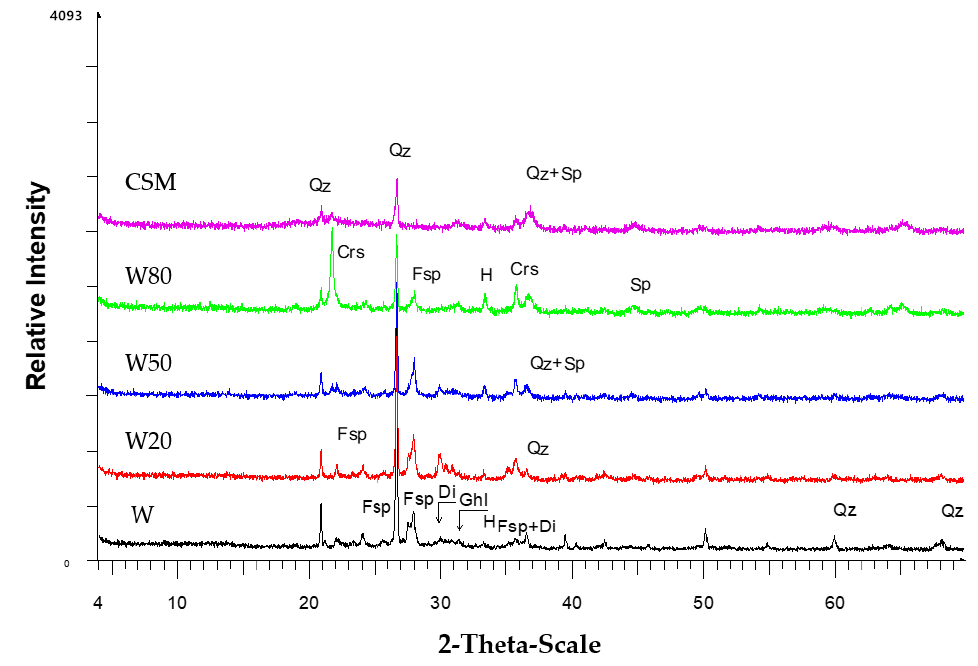
Figure 4. Powder X-ray diffraction patterns of the fired samples at 1000 °C. Abbreviations: Qz—quartz, Crs—cristobalite, Sp—spinel, Fsp—feldspar, Di—diopside, Ghl—gehlenite, H—hematite.